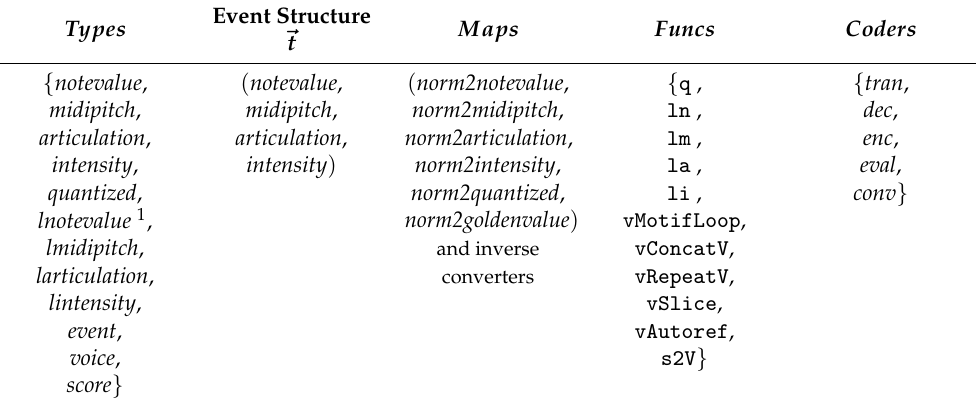
Table 4. Minimal elements in piano species required to model Clapping Music